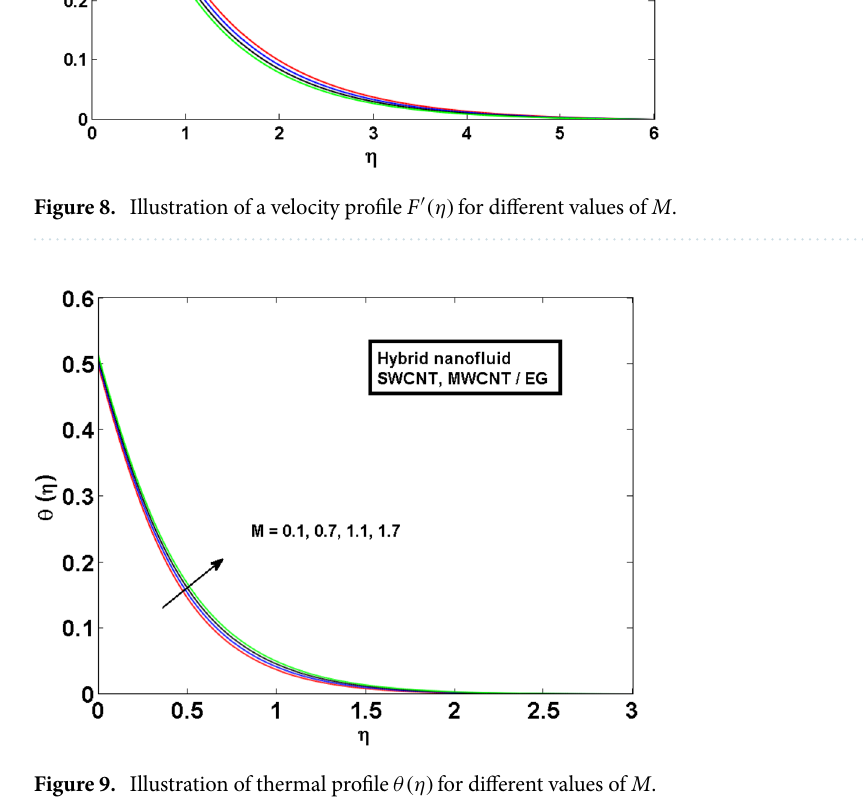
Figure 9. Illustration of thermal profile θ(η) for different values of M .